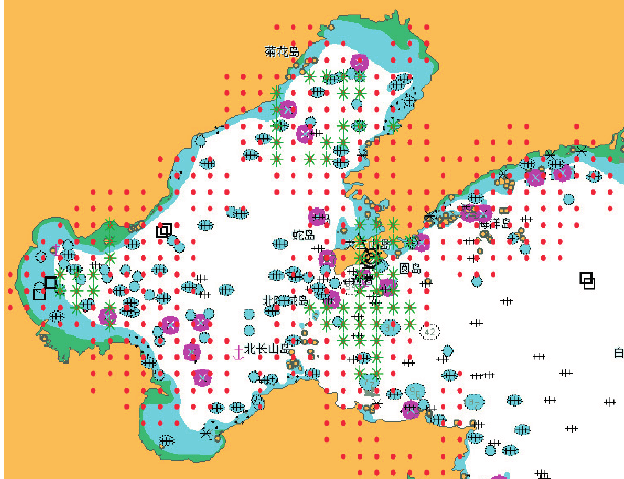
Figure 4. Signal coverage area of AIS base station in the North Sea